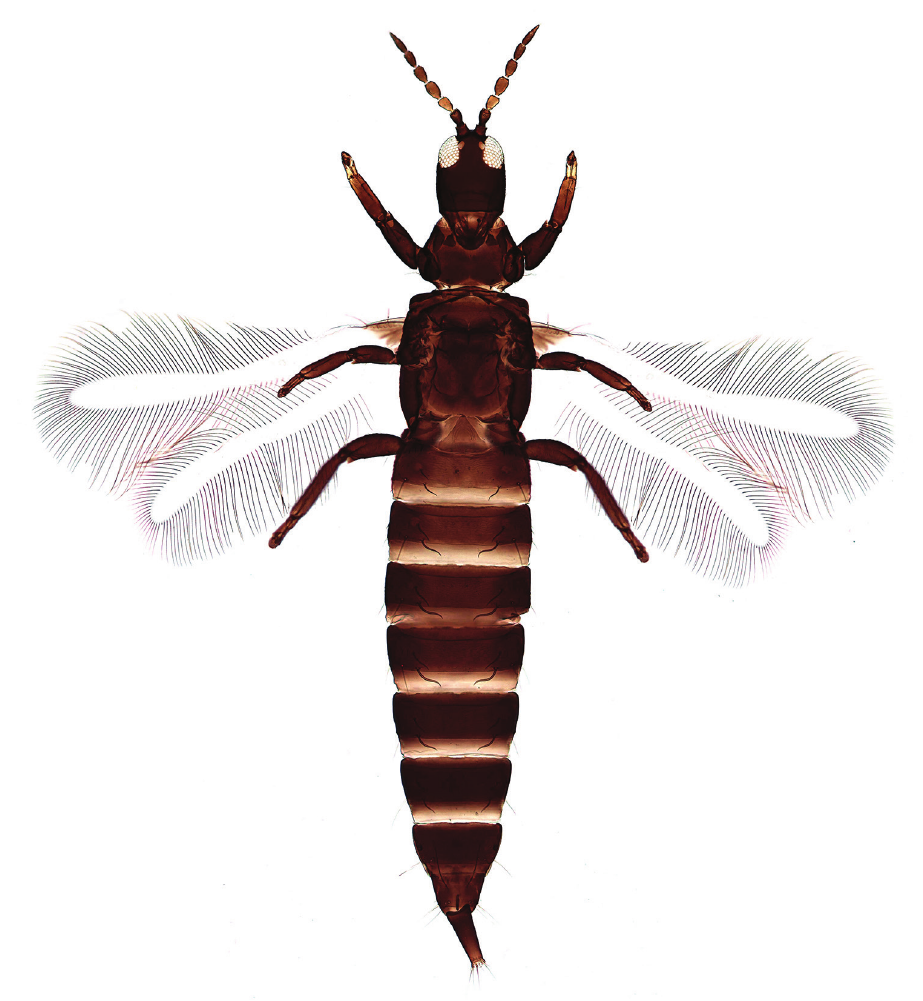
Figures 1. Haplothrips shivendraii sp. n.: